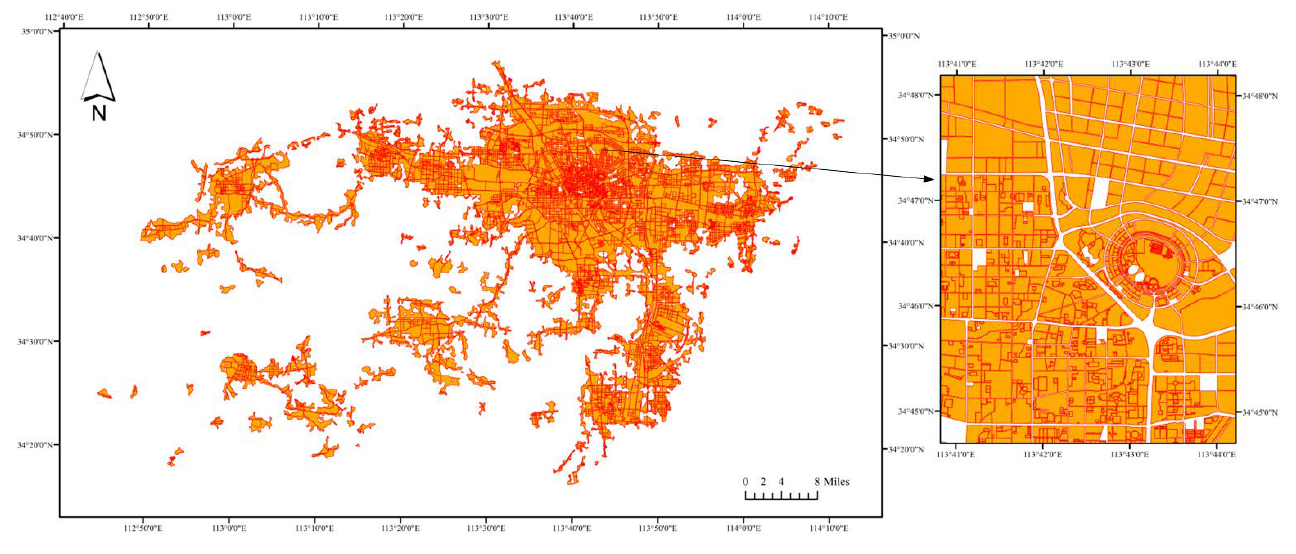
Figure 5. Urban parcels. Table 7. Sample size and feature classification results for each experimental group. The bolded content is the best